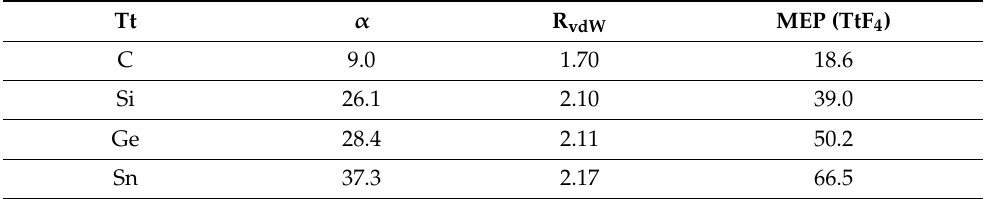
Table 1. Atomic polarizabilities ( α , a.u.) of tetrel (Tt) elements, van der Waals radii (in Å) and σ –hole